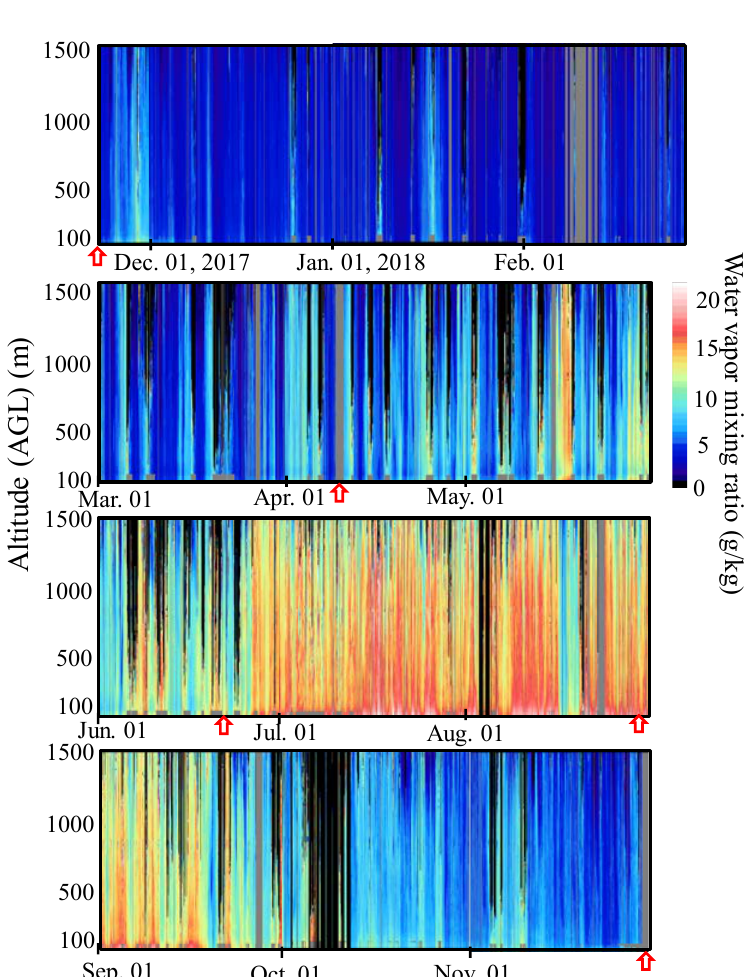
Figure 3. Time-height cross sections of the water vapor mixing ratio profiles observed by the Raman lidar at Shigaraki, Japan, from November 24, 2017, to November 29, 2018. Red arrows in x-axis correspond to the time of replacing the flash lamp of the